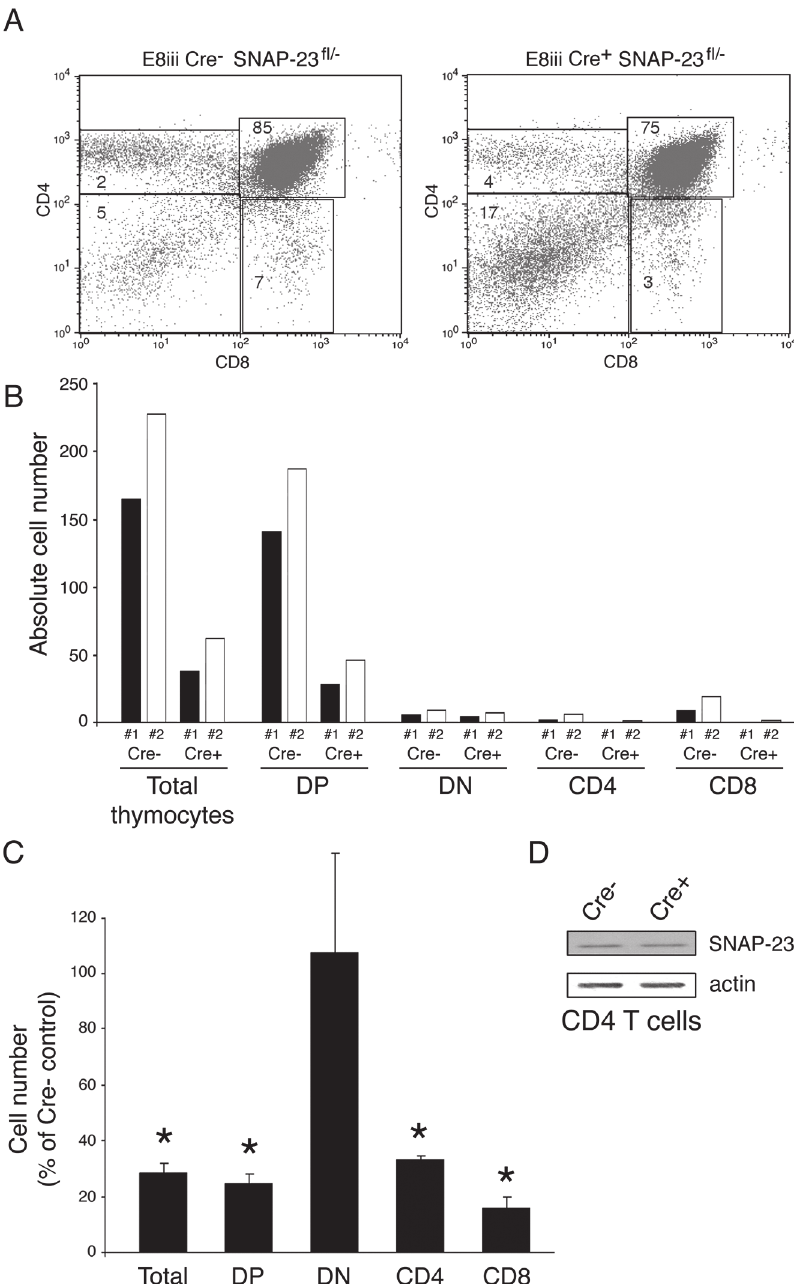
Fig 4. Deletion of SNAP-23 in CD4 + CD8 + T cells prevents T cell development. Thymi were harvested from E8iii-Cre - SNAP-23 fl/- control mice or E8iii-Cre + SNAP-23 fl/- mice (line E3) and single cell suspensions were stained with fluorochrome-conjugated CD4- and CD8-mAb and analyzed by flow cytometry. (A) A representative flow cytometry profile reveals a dramatic reduction in the percentage of CD4 + , CD4 + 8 + , and CD8 + T cells in the thymus of an E8iii-Cre + -expressing SNAP-23 fl/- mouse. (B) Quantitative analysis of matched pairs of Cre - and Cre+ SNAP-23 fl/- littermate mice lines indicate recovery of CD4 - CD8 - (DN), CD4 + CD8 + (DP), CD4 + , and CD8 + T cells present in thymi of E8iii-Cre + SNAP-23 fl/- mice expressed as a percentage of those found in thymi of E8iii-Cre - SNAP-23 fl/- control mice (calculated based on the percentage of each cell type present as determined by flow cytometry). (C) The recovery of the indicated cell types from the thymi of E8iii-Cre + SNAP-23 fl/- mice was expressed as a percentage of those found in E8iii-Cre - SNAP- 23 fl/- control mouse spleens. The data shown are mean +/- SD of five independent experiments ( * p < 0.05). (D) CD4 T cells were purified from the thymi from the indicated mice and equal numbers of cell